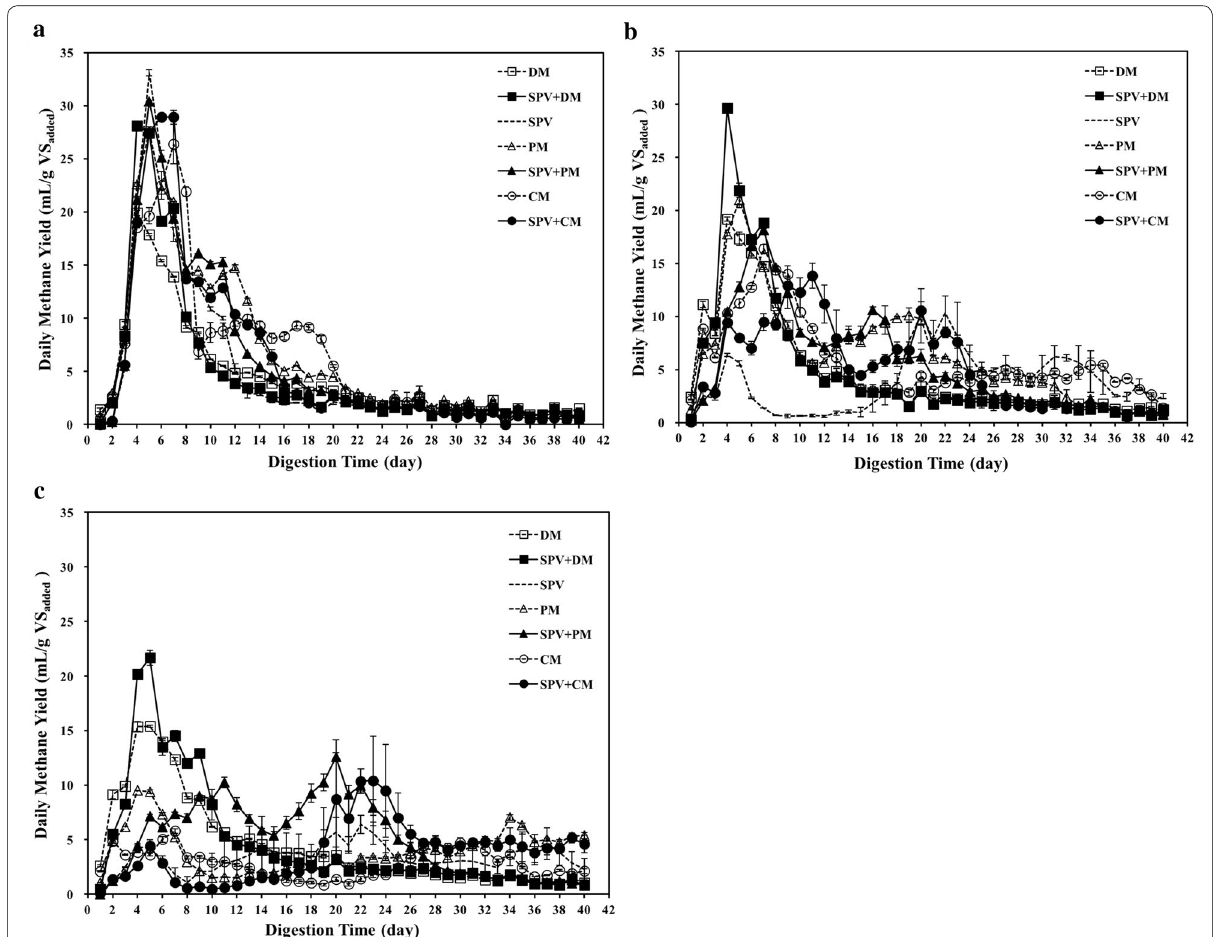
Fig. 1 Daily methane production performance from SPV and the mixtures with animal manure in a W-AD, b SD-AD and c D-AD